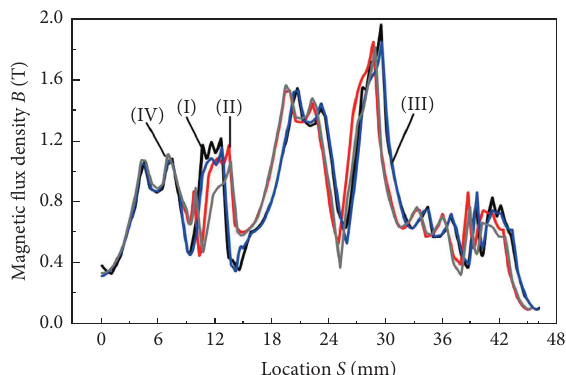
Figure 7: Magnetic field distribution in magnetic fluid sealing clearance under different axial clearances (I), 0.4mm; (II), 0.5mm; (III), 0.6mm; and (IV), 0.7